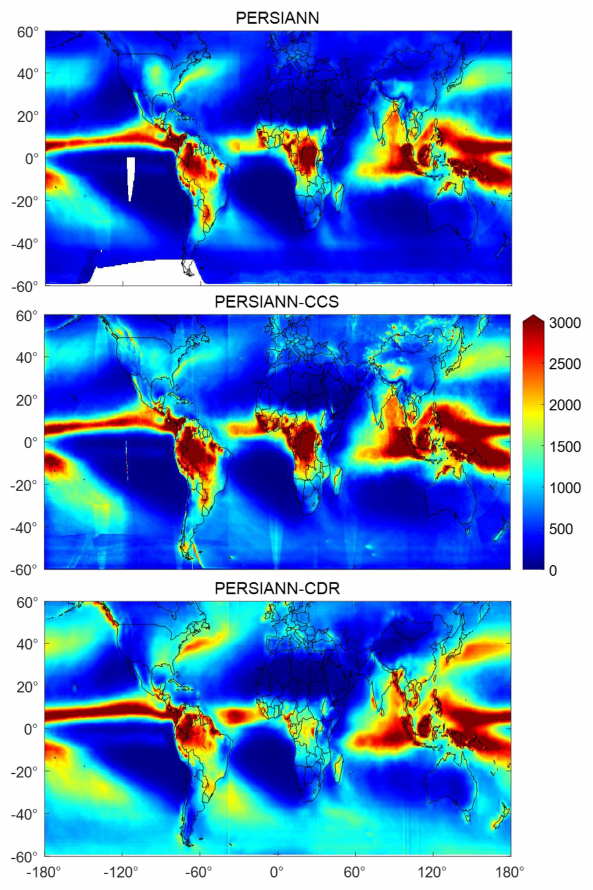
Figure 8. Mean annual meridional precipitation (mmyr − 1 ) for PERSIANN, PERSIANN-CCS, and